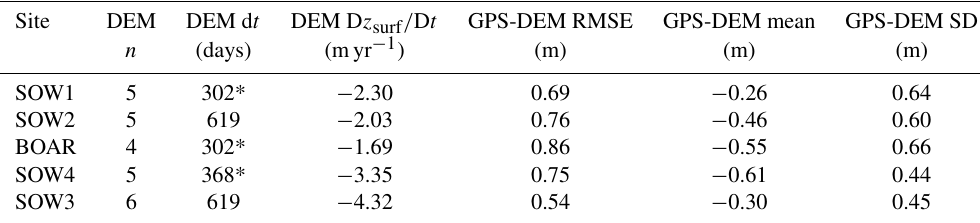
Table 2. Statistics for WorldView DEM accuracy from comparisons with measured GPS surface elevation data. Asterisks identify records with shorter time interval and increased uncertainty. Site DEM DEM d t DEM D z surf / D t GPS-DEM RMSE GPS-DEM